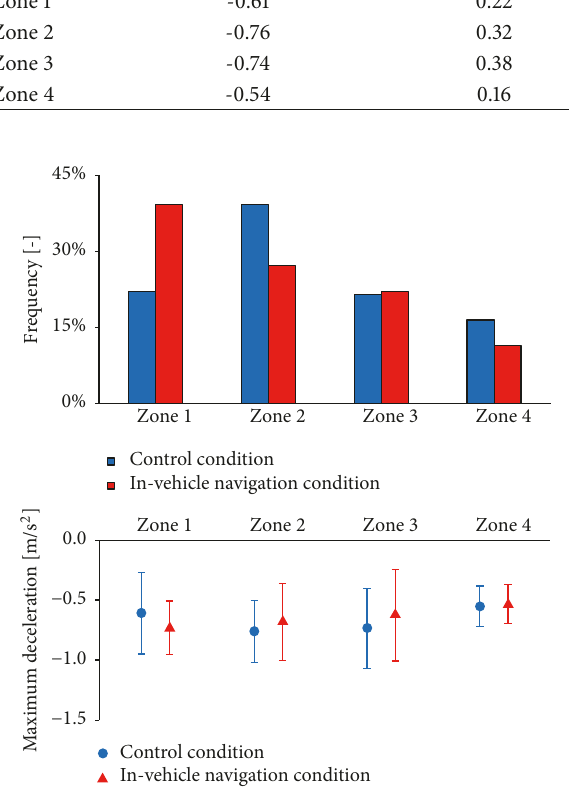
Figure 9: Maximum deceleration of drivers under two